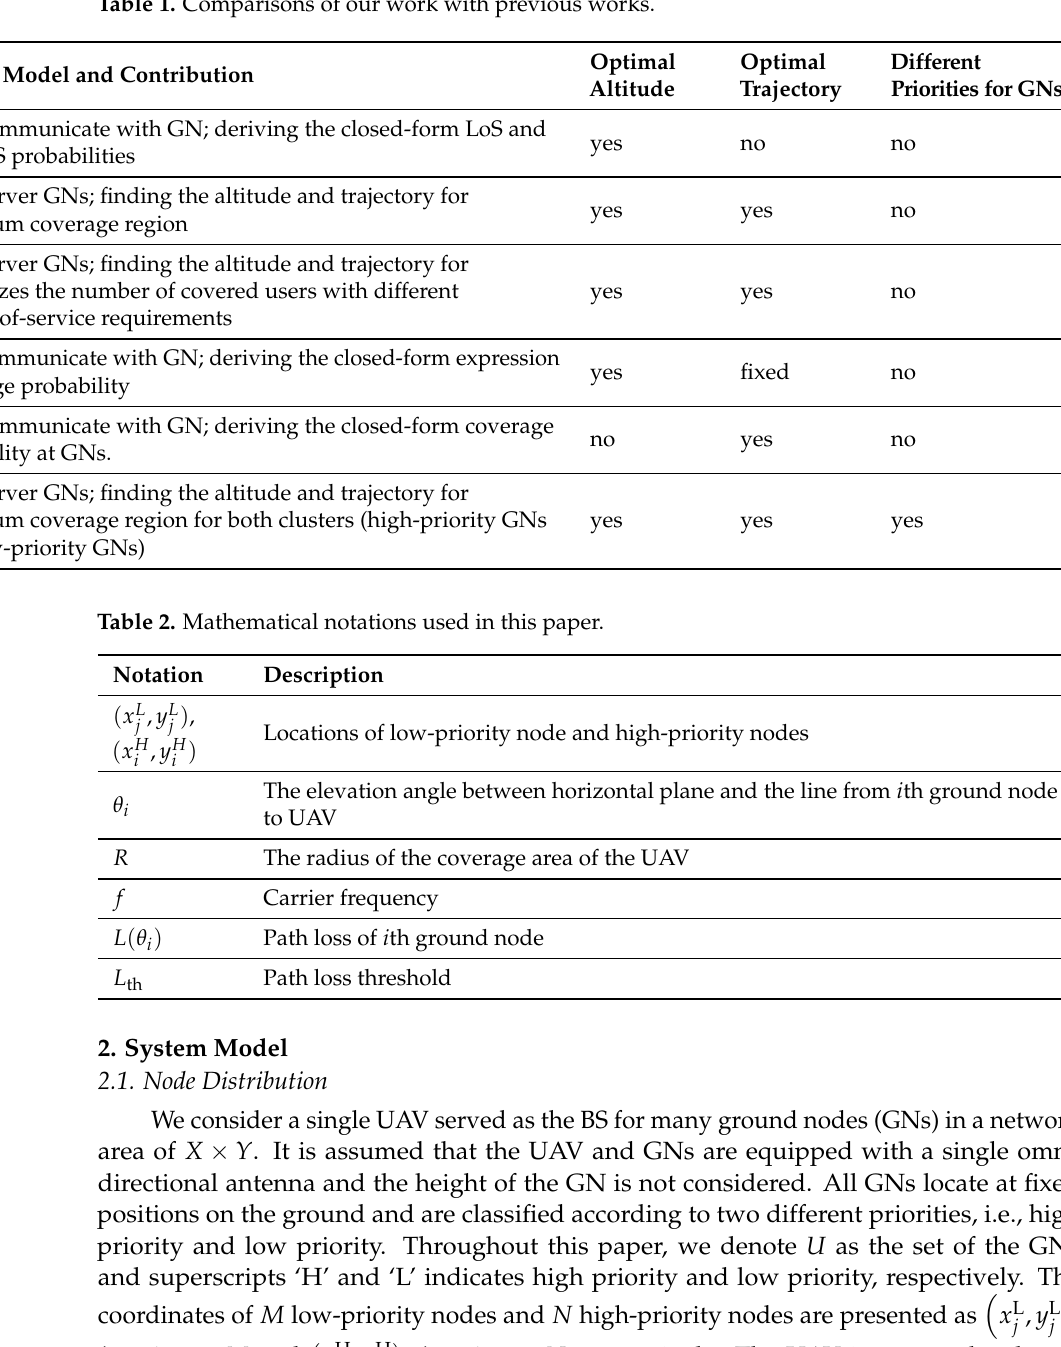
Table 1. Comparisons of our work with previous works.